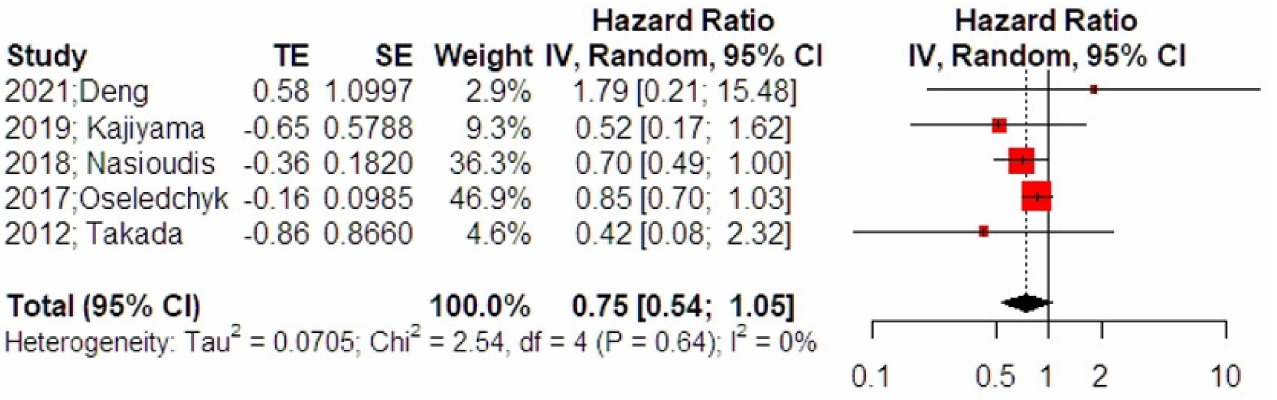
Figure 3. Forest plot of overall survival among patients with intraoperative cyst rupture that received chemotherapy compared to those treated with expectant management (right side): Vertical line = “no difference” point between the two groups. Red squares = odds (hazard) ratios; diamond = pooled mean odds (hazard)radio and 95% CI for all studies; horizontal black lines = 95% CI